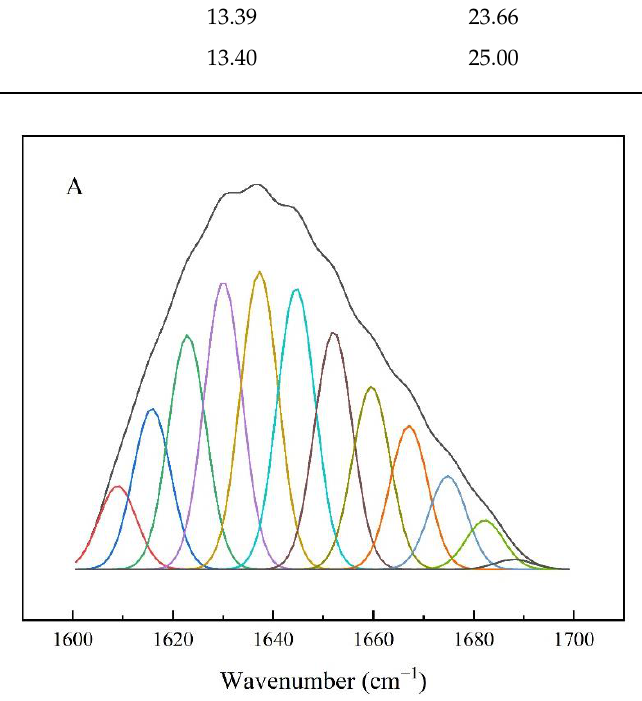
Figure 18. Infrared spectrum.